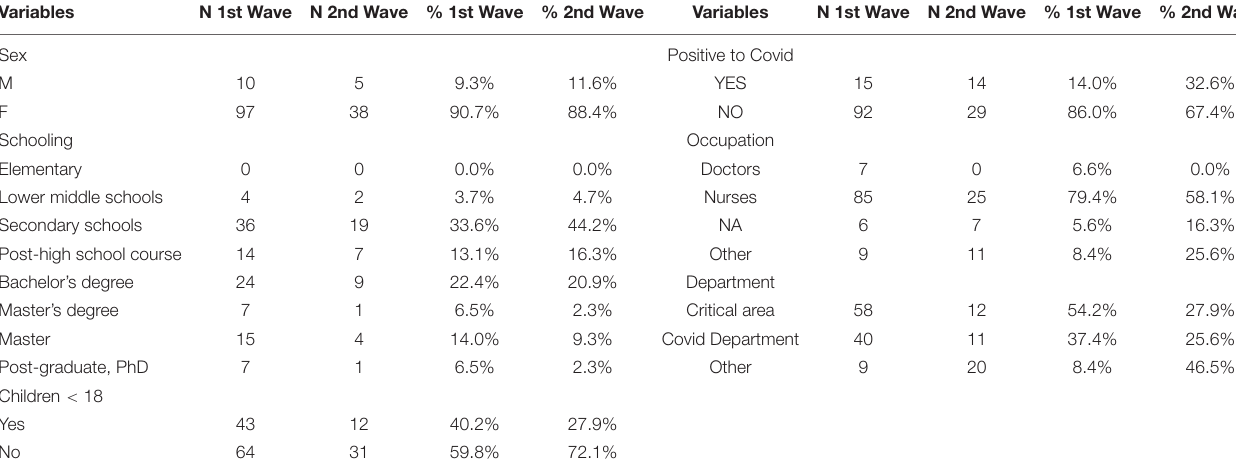
FIGURE 1 | Research design. TABLE 1 | Significant sociodemographic, occupational, and clinical